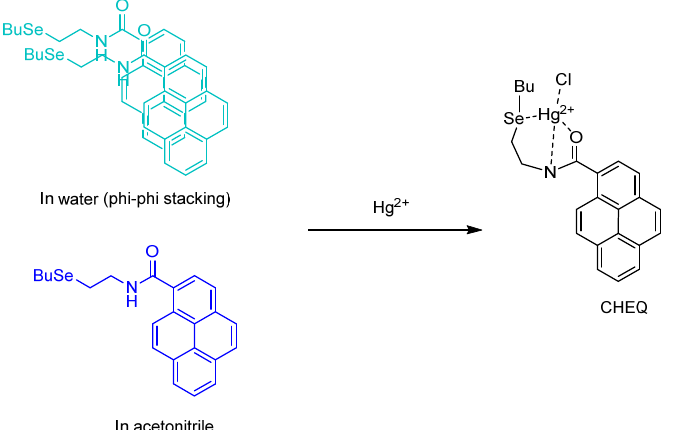
Figure 17. The selenium-containing probe by Gonçalves et al. that engages in π – π stacking and binds to mercury.